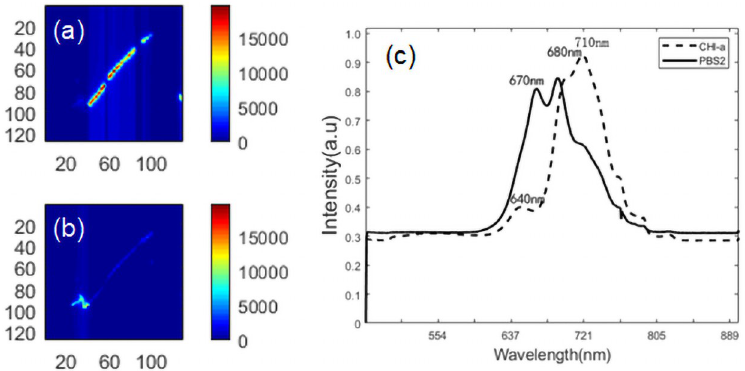
Fig 4. MCR analysis of algal cells for Anabaena flosahuas. (a) Concentration image of PBS resulting from MCR analysis of the entire spectral area. (b) Concentration distribution images of Chl-a resulting from analysis of the entire spectral area using MCR. (c) Pure spectral profile of chlorophyll (dotted line) and PBS (solid line).